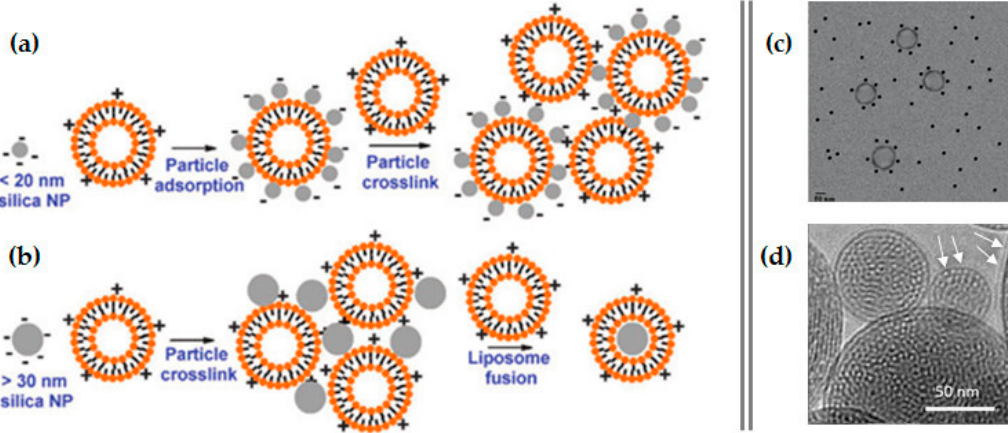
Figure 14. Illustrative representation of the interaction between silica nanoparticles and cationic liposomes ( a , b ), and TEM images ( c , d ) of the respective results: ( a ) Small silica NPs are adsorbed onto the liposomes, resulting in a negatively charged surface. ( b ) Larger silica NPs lead to the formation of supported bilayers with a positively charged surface, which are useful for DNA binding. ( c ) TEM image of 10–20 nm silica NPs prepared with 1,2-dimyristoyl-sn-glycero-3-phosphocholine (DMPC) small unilamellar vesicles. ( d ) Cryogenic TEM image of the protocell, showing the mesoporous silica nanoparticle core and the SLB (white arrows). (( a , b ) adapted from [104] with permission from Royal Society of Chemistry; ( c ) Adapted from [107] with permission from American Chemical Society; ( d ) adapted from [108] with permission from Elsevier).